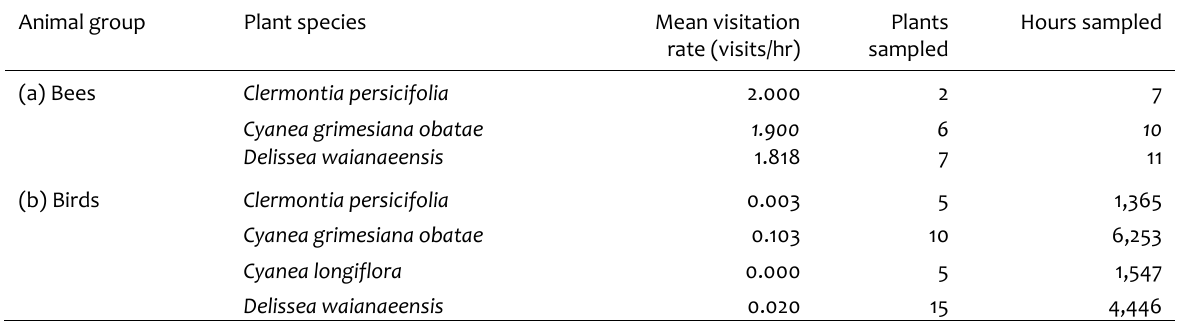
Table 3. Visitation rates per hour to individual plants by (a) bees and (b) birds for each plant species. For bees, visitation rates are based on in-person observations and for birds, visitation rates are based on game